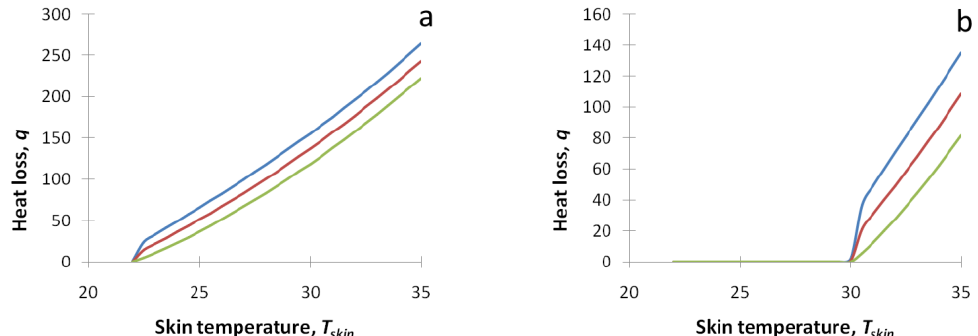
Figure 2. The dependence of the heat loss function, q [W/m 2 ], on the skin temperature T skin [°C] in the case of moist skin ( W = 1). q ( T skin ) for was plotted for T ∞ = 22 °C ( panel a ) and 30 °C ( panel b ). Relative air humidity was set to 40% (blue line), 70% (red line), and 100% (green line). Skin emissivity ε was set to 0.98.